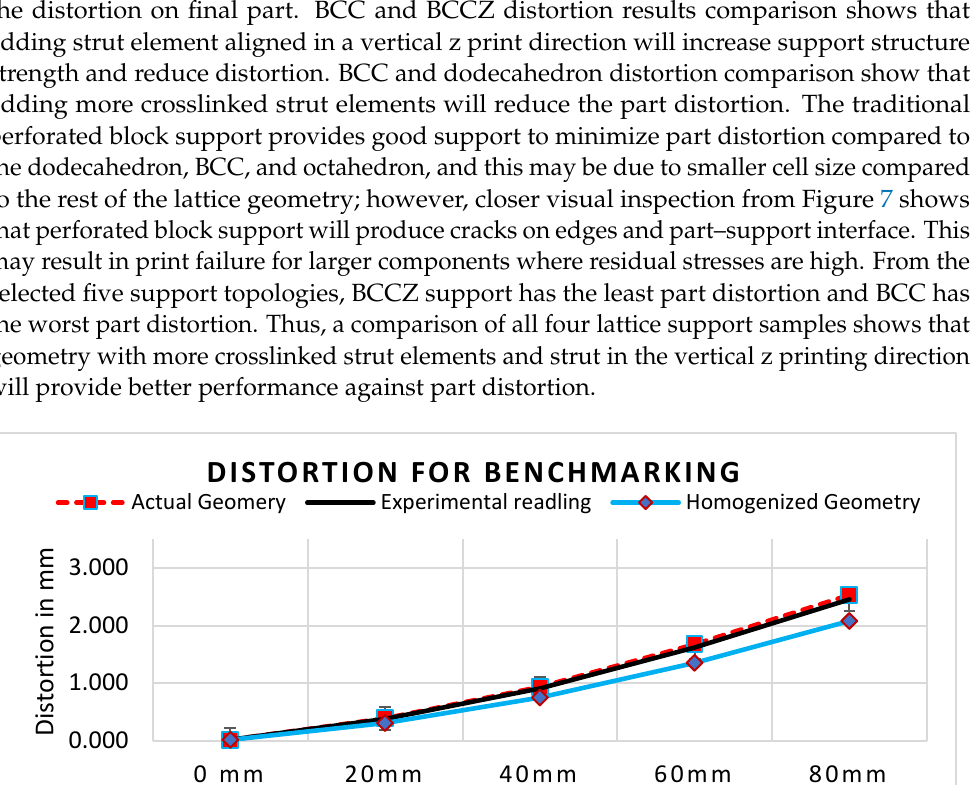
Figure 9. Printed test sample with two different volume fractions.